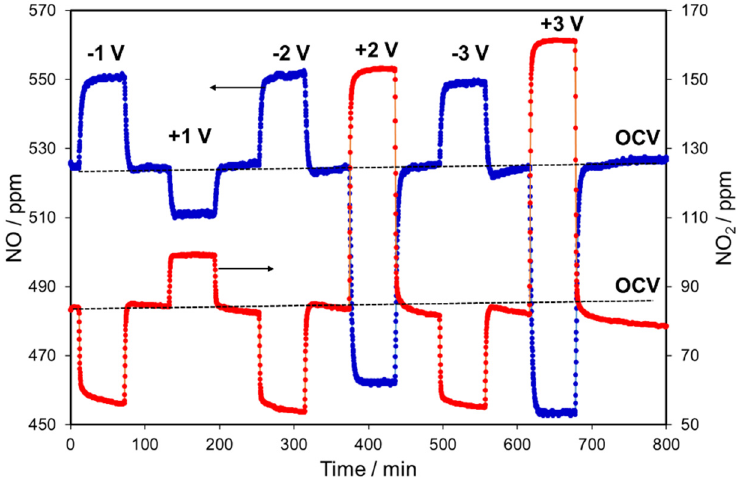
Figure 8. Variations of NO and NO 2 concentrations with time at 400 ◦ C upon polarizations. Reactive mixture: NO/NO 2 /O 2 : 525 ppm/85 ppm/1% in